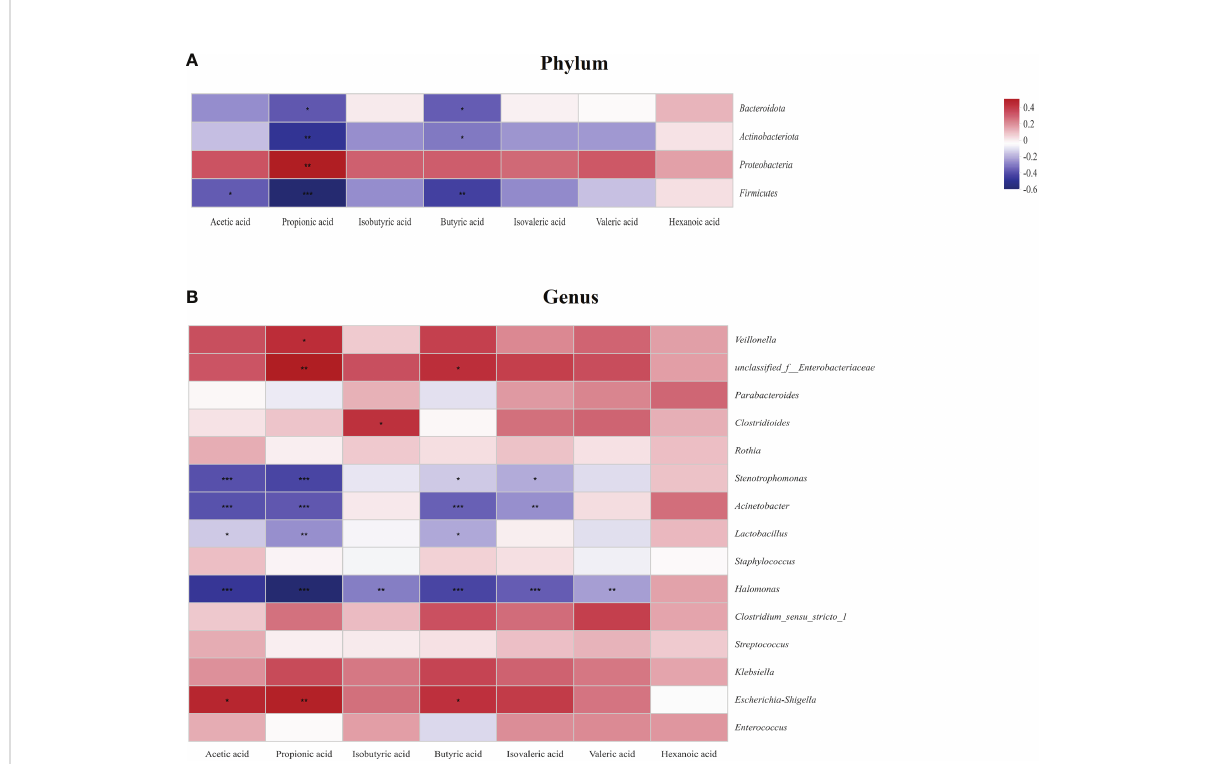
FIGURE 9 Relationship between the gut microbiota and short chain fatty acids (SCFAs) at the phylum level (A) and the genus level (B) in the study. Some fl ora and SCFAs were negatively related, represented in blue, and others were positively related, represented in red. The darker the color, the higher the correlation was. * P <0.05, ** P <0.01, and *** P <0.001. Data was presented as means±SEM, N=22 for necrotizing enterocolitis (NEC) and N=21 for food protein-induced allergic protocolitis